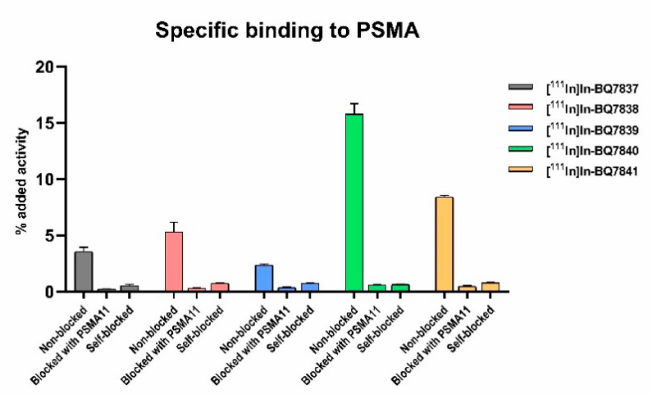
Figure 3. In vitro binding specificity of [ 111 In]In-BQ7837-41 (SET 1) in PSMA-expressing PC3-pip cells. To block PSMA, 500 nM/well of non-labelled PSMA-11 or the non-labelled variant of the PSMA- binding ligand of interest were used. For all analogues, the same concentration of radiolabelled PSMA-binding radioligand was added to all wells. Statistical analysis was done using an unpaired, two-tailed t